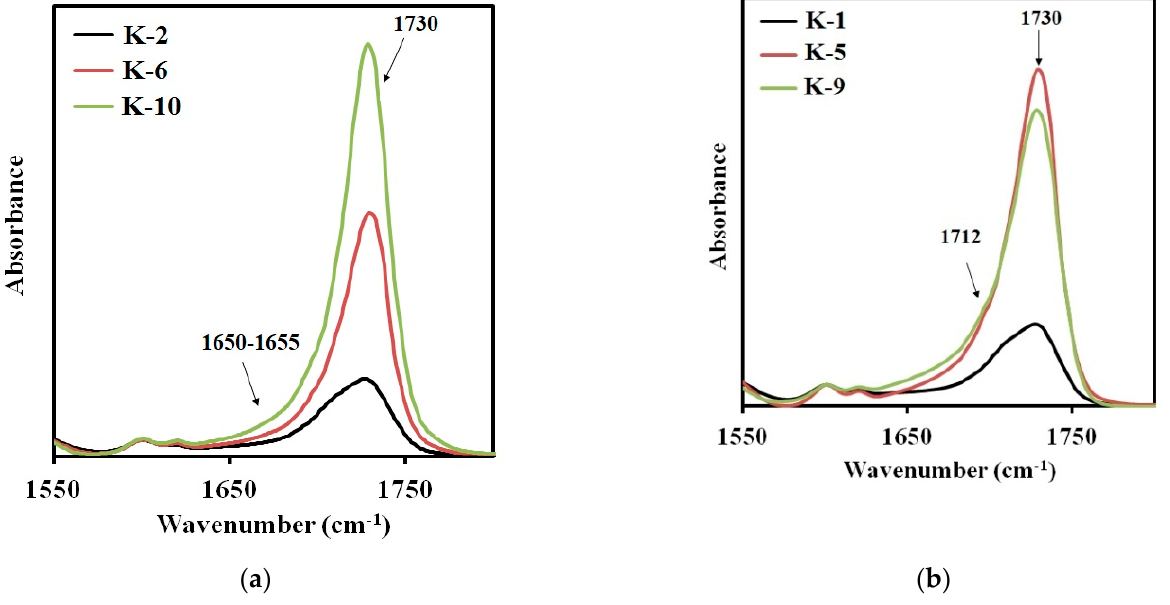
Figure 7 . Sections of the FTIR spectra for the samples: ( a ) K–2, K–6, K–10; ( b ) K–1, K–5, K–9.